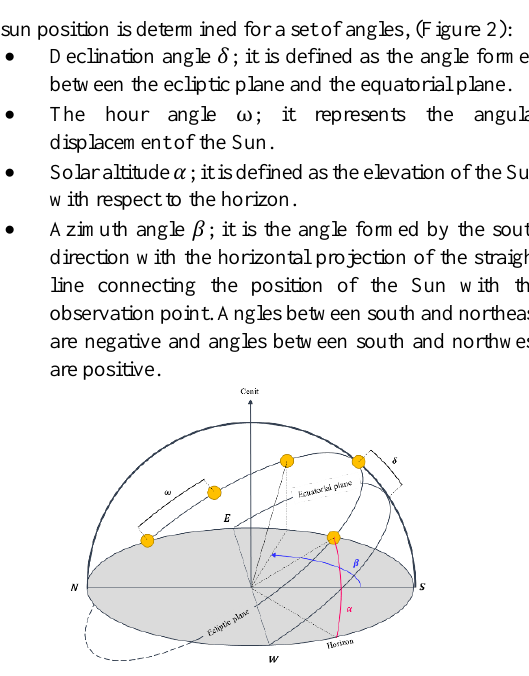
Figure 2. Solar angles: Declination 𝛿 , hour angle 𝜔 , azimuth angle 𝛽 and solar altitude